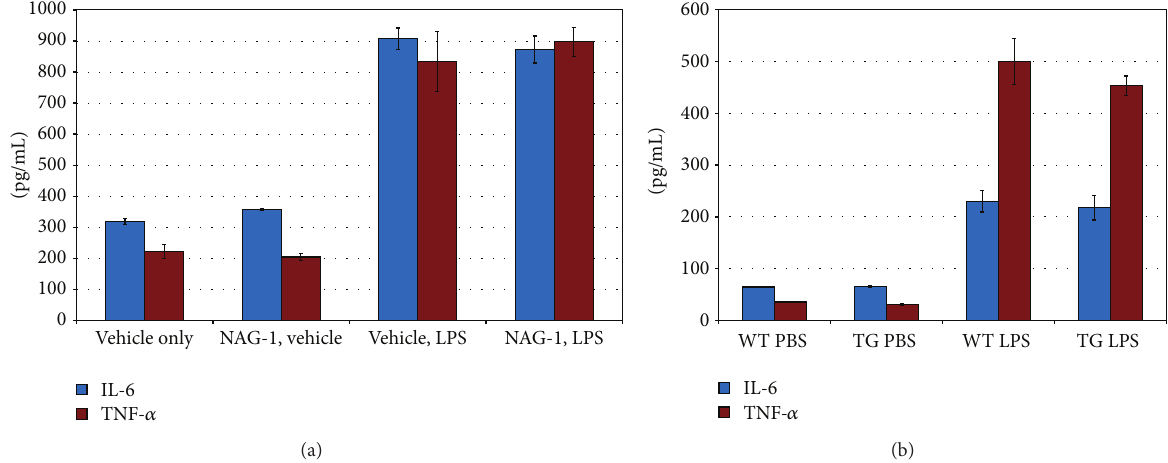
Figure 4: NAG-1 does not affect inflammatory cytokine production from Kupffer cells. (a) Kuppfer cells isolated from the livers of WT mice were plated in triplicate onto 6-well plates and cultured for 24hrs in RPMI. Media were collected at the beginning of an experiment and cells were then refed and incubated with media containing recombinant human GDF-15 (50ng/mL) or vehicle for 2 hours and then LPS (10ng/mL) or vehicle for 6 hours, prior to media collection. TNF- 𝛼 and IL-6 levels in the media were measured in duplicate using cytokine- specific ELISAs. The mean concentrations for each treatment are plotted. Error bars represent standard error. (b) Kupffer cells isolated from the livers of WT or 𝑁𝐴𝐺 - 1 𝑇𝑔/𝐿𝑜𝑥 mice were plated in triplicate onto 6-well plates and cultured for 24 hrs in RPMI. Media were collected at the beginning of an experiment and cells were re-fed and incubated with media containing LPS (10ng/mL) or vehicle and incubated for 6 hours prior to collection of media. TNF- 𝛼 and IL-6 levels in the media were measured in duplicate using cytokine-specific ELISAs. The mean concentrations for each treatment are plotted. Error bars represent the standard error of the